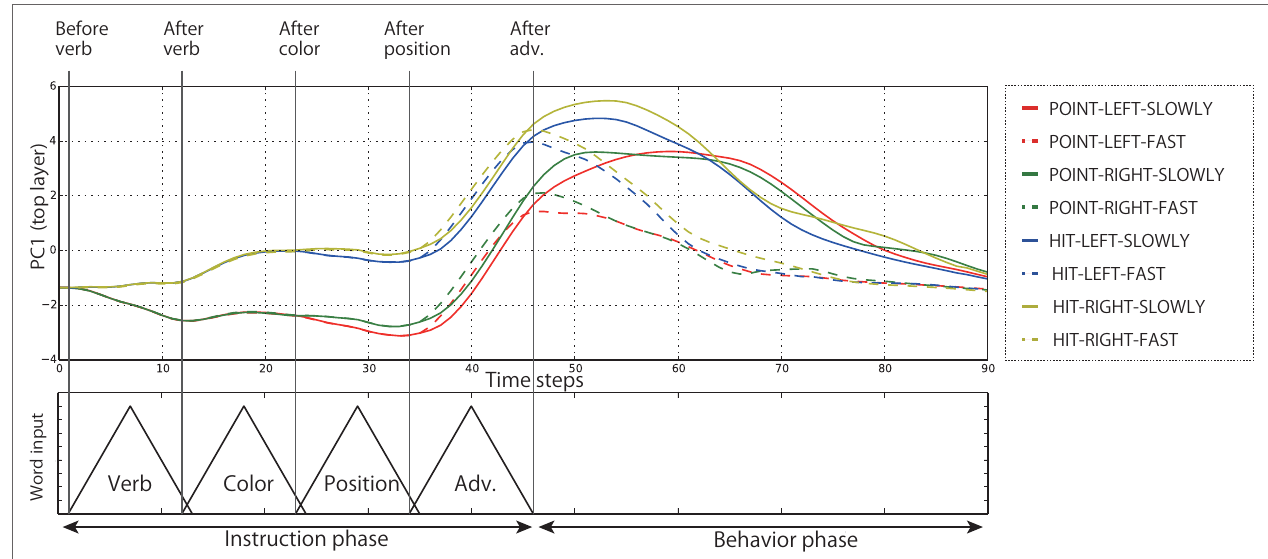
FIGURE 9 | The time development of the internal states in the top layer in the PC1 direction . Each line expresses the time development averaged over all the episodes in which each behavior was generated during evaluation. Note that only the episodes in which the instruction consists of four words were included. In the cases of 4-word instruction, the robot cannot identify which of the bells the color word indicates. In these cases, the internal states first branched by receiving the verb but were not bifurcated by the following color word. After that, they were bifurcated twice by a position word and an adverb, and eventually reached the appropriate activation.